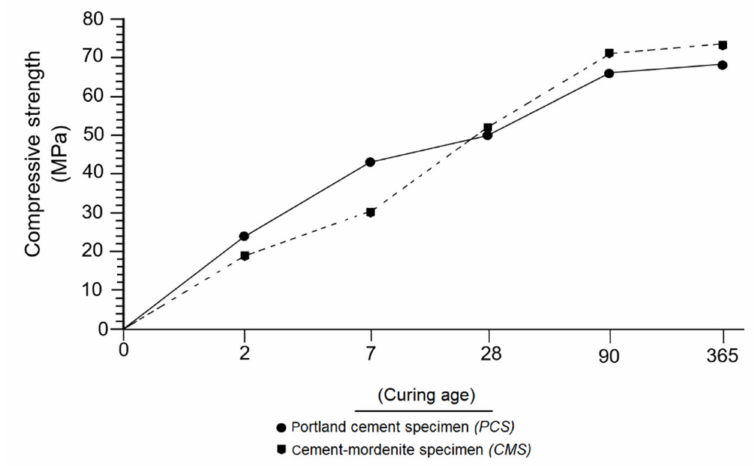
Figure 13. Evolution over time of the compressive strength of CMS and PCS.